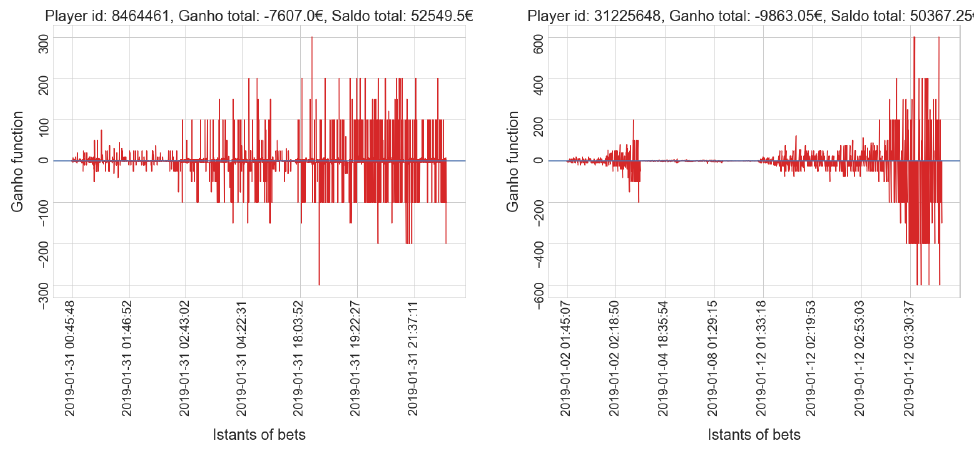
Figure 22. Time series plot of two players in Cluster 3.